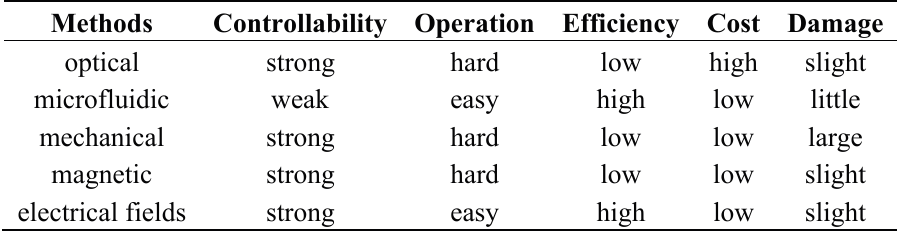
Table 1. The comparison of different particle control